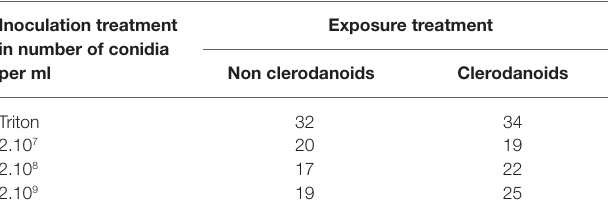
TABLE 1 | Number of adult sawflies, which where either exposed or not to the plant Ajuga reptans , for uptake of clerodanoids, and then inoculated with different concentrations of B. bassiana